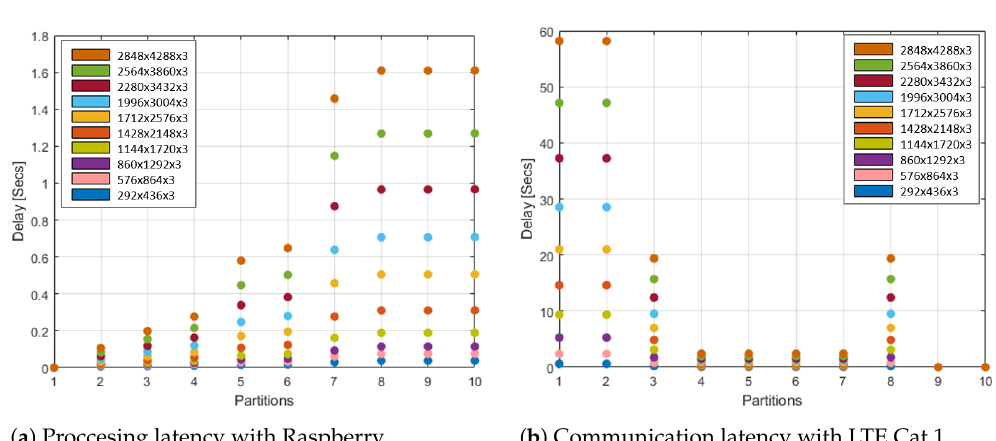
Figure 7. Latency per partition along the system as a function of the image size for an image with 18 objects. The processing latency of partition j is the sum of the processing latencies of all tasks 1 to j . The communication latency of partition j is the latency of communicating the output data of task j over the wireless communication link.